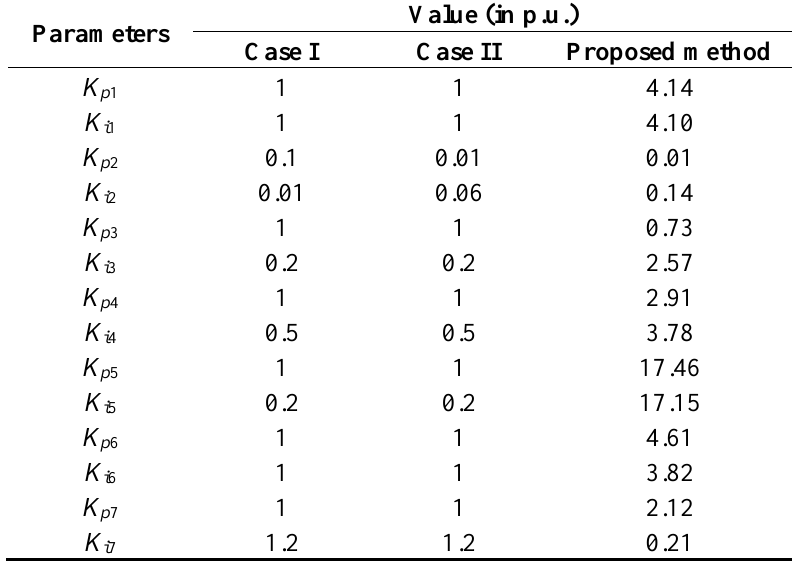
Table 1. PI controller parameters for three cases at v w0 = 8 m/s.